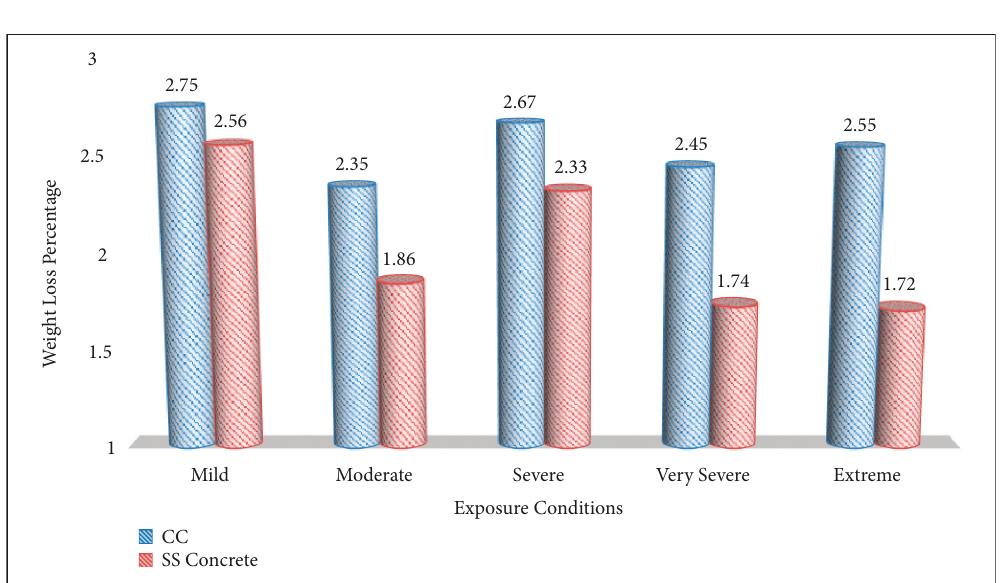
Figure 10: Comparison of weight loss percentage of CC and SS concrete in HCl acid attack.